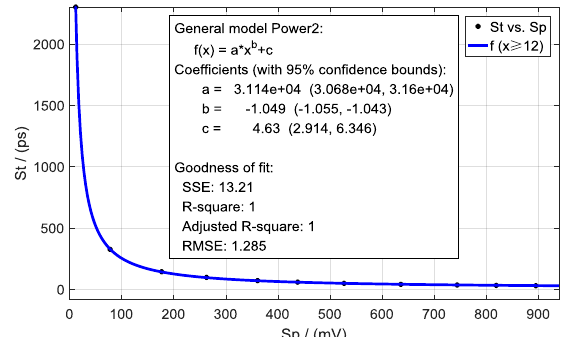
Figure 5. The relationship between different peaks and timing points with the general model Power2